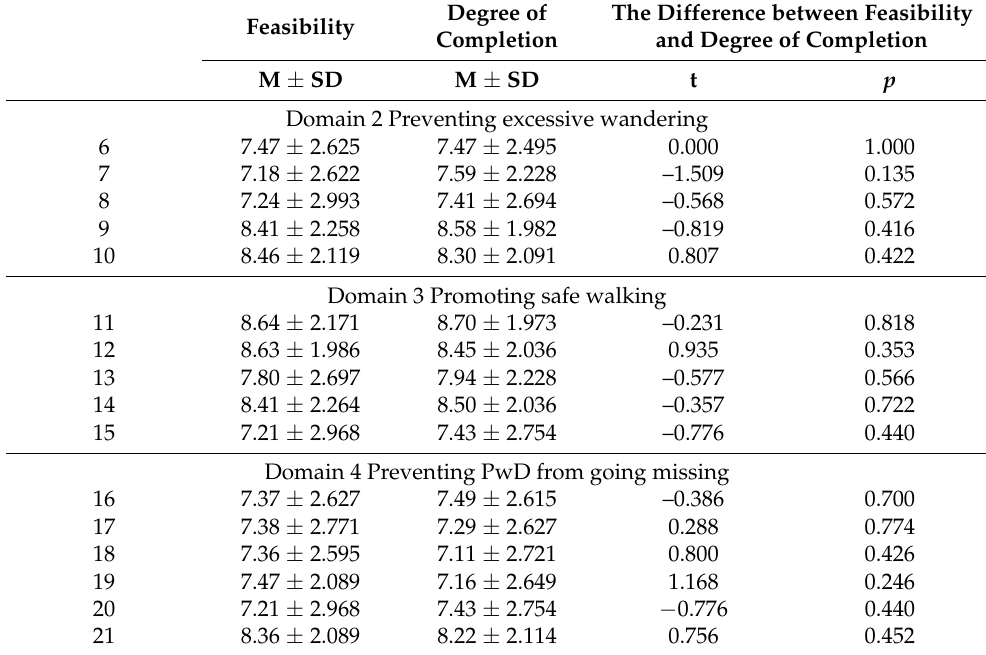
Table 3. Descriptive analysis and comparison of feasibility and degree of